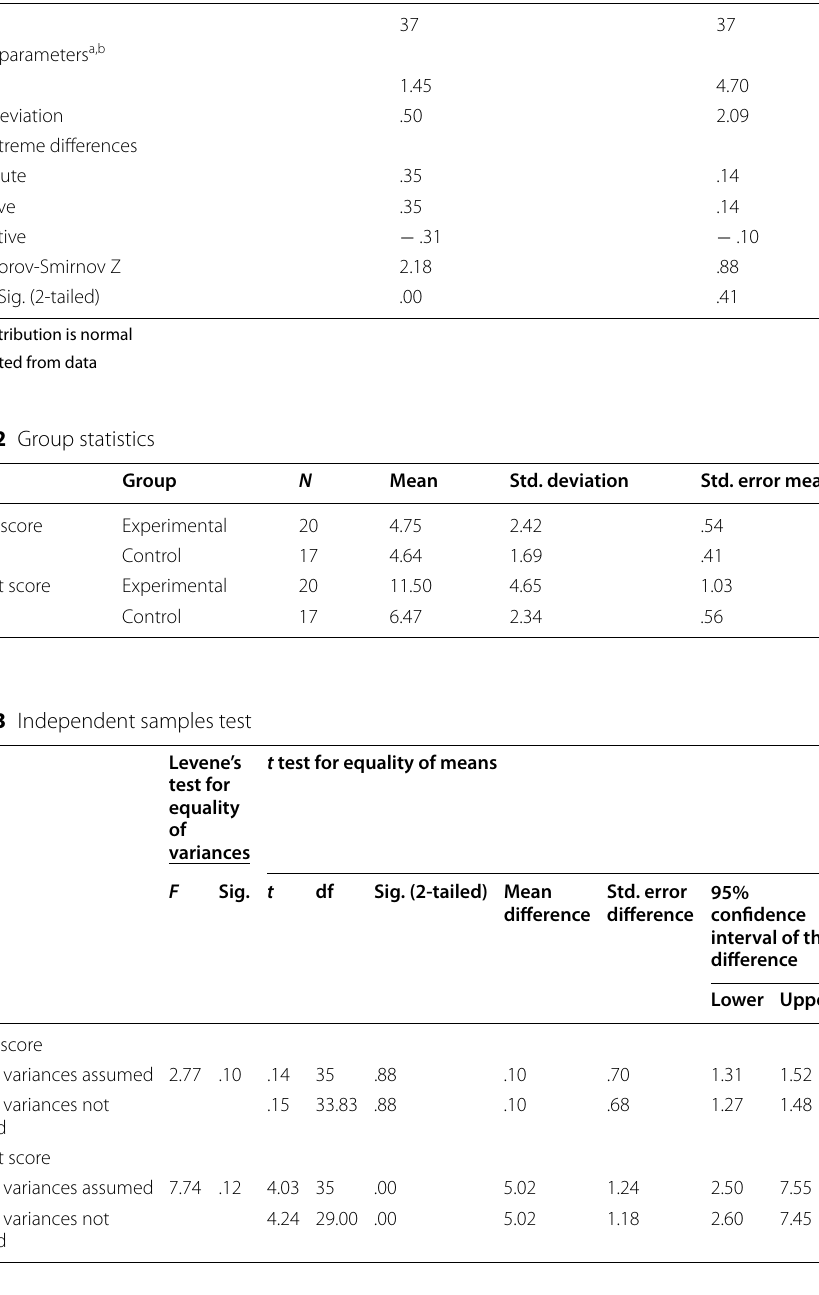
Group Pre-test score